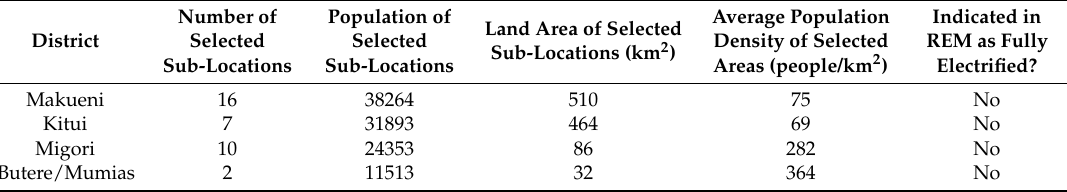
Table A2. Shortlisted pre-2010